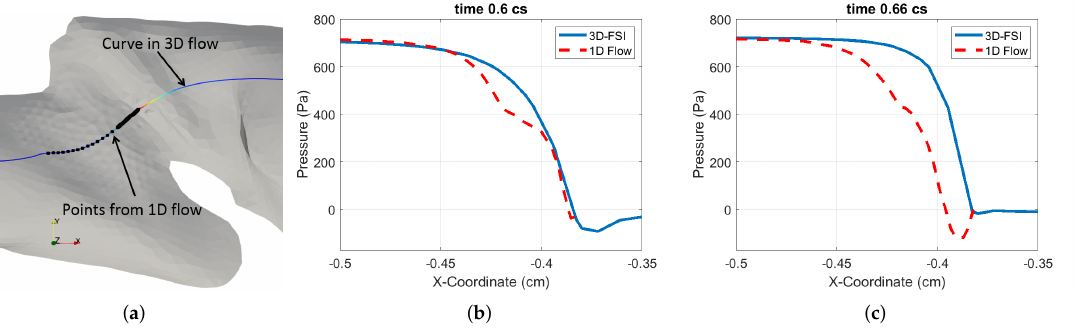
Figure 8. ( a ) Sample 3 model showing a streamline and the points (black markers) on it, along with the 1D flow model applied. ( b , c ) Pressure plot on the points from the 1D flow model (dashed) and 3D FSI model at an open state ( t = 0.6 cs) ( b ) and closed state ( t = 0.66 cs) ( c ).